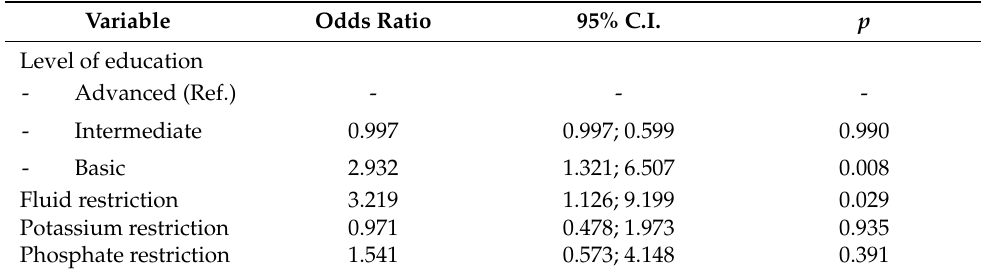
Table 3. Multivariable logistic regression for inadequate adherence to the Mediterranean diet in the whole population, including level of education and dietary